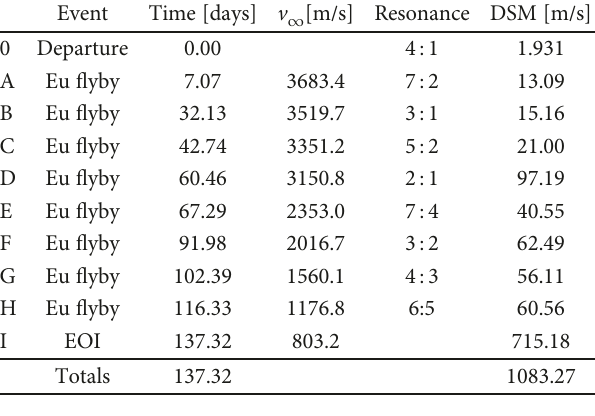
Table 1: Solution “ A ”— mission features.